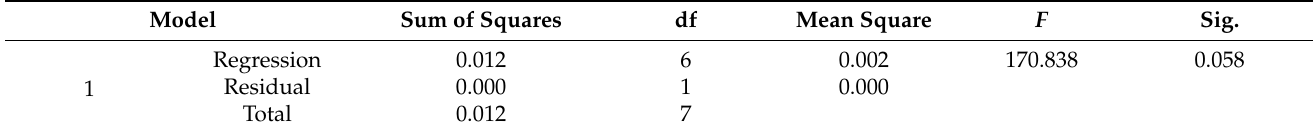
Table 8. Variance analysis of 6 variables.